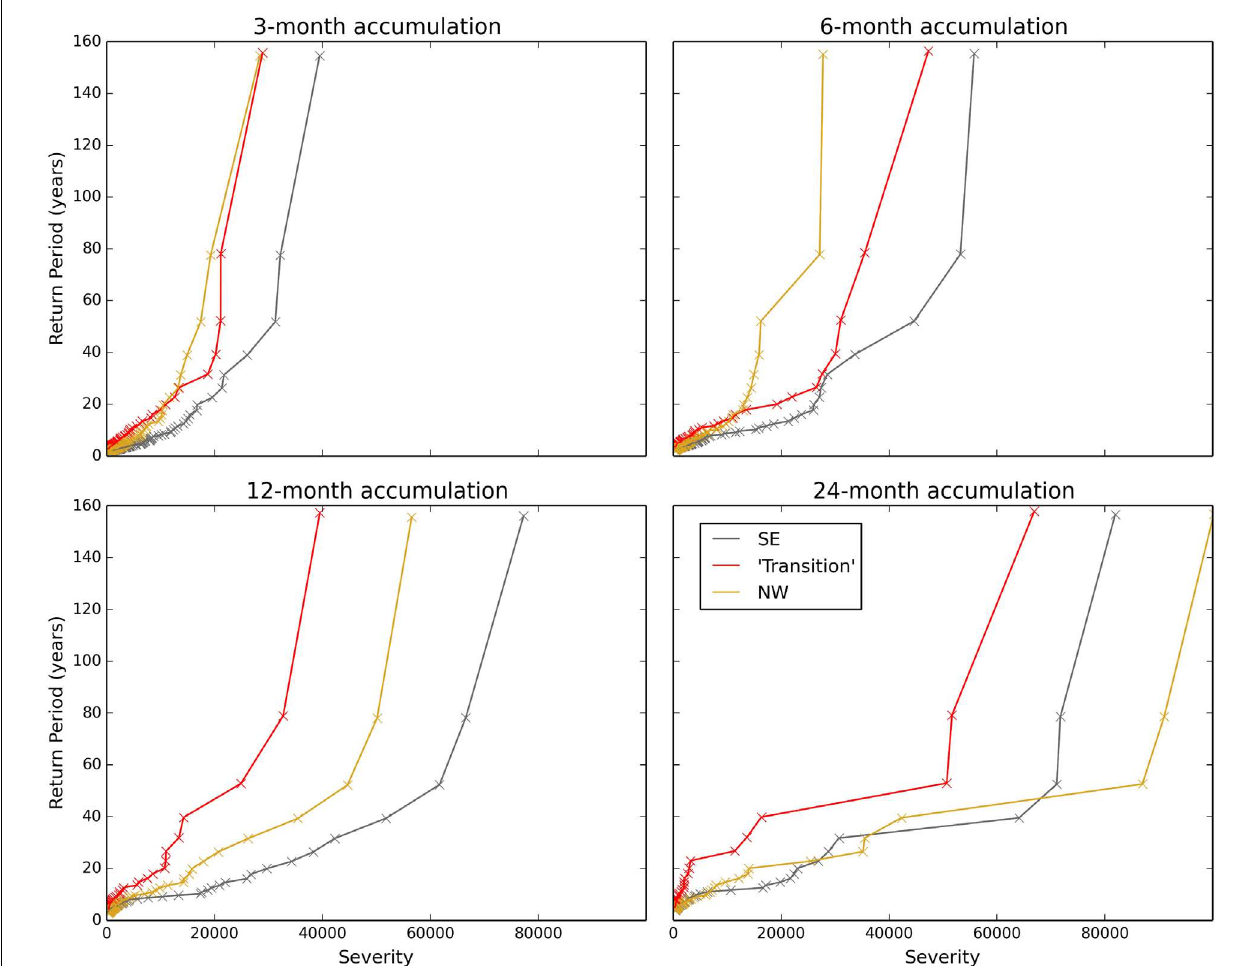
FIGURE 6 | Return period of drought events calculated based on their severity for the three regions of GB, and for different accumulation period of precipitation (3, 6, 12, and 24